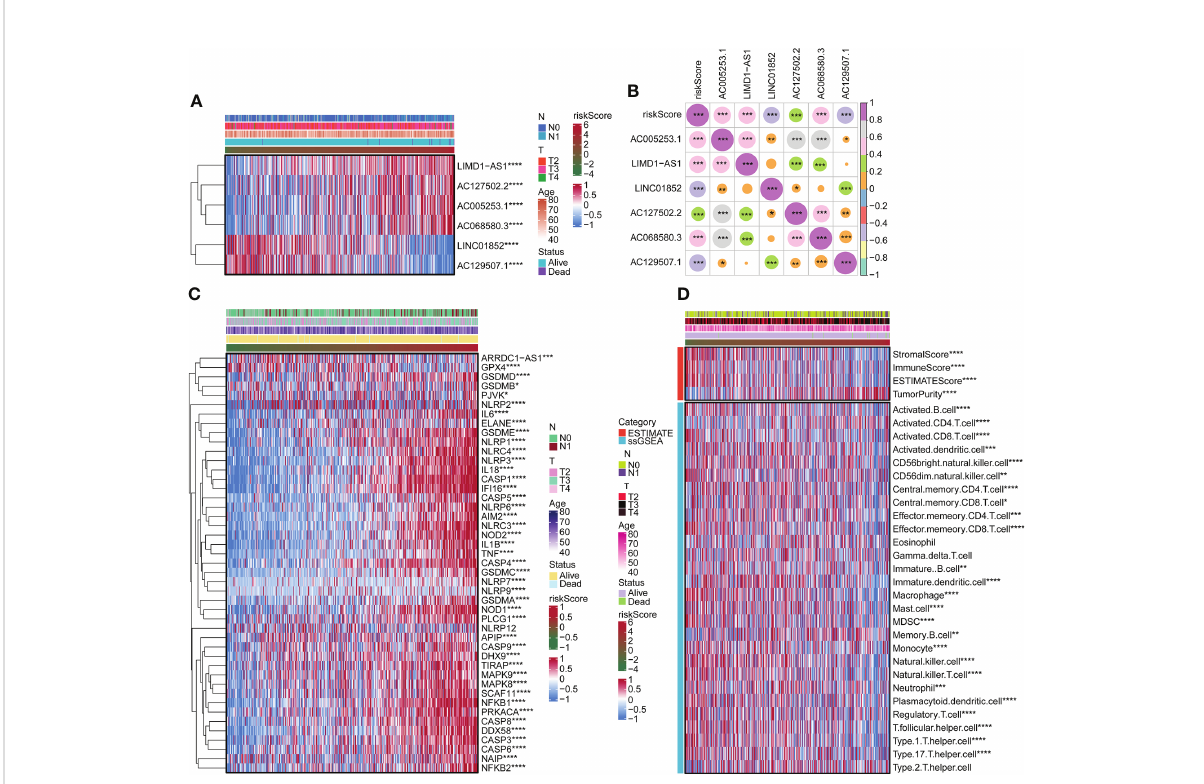
FIGURE 2 Correlation of risk scores with pyroptosis genes and immune in fi ltration. (A) The expression of LIMD1-AS1, AC127502.2, AC005253.1, AC068580.3, LINC01852, and AC129507.1. (B) Expression correlation plots of risk scores and model genes. (C) Heatmap of risk score associated with pyroptosis genes. (D) Heatmap of the relationship of the risk score to immune in fi ltration. *p < 0.05. **p < 0.01. ***p < 0.001 ****p <